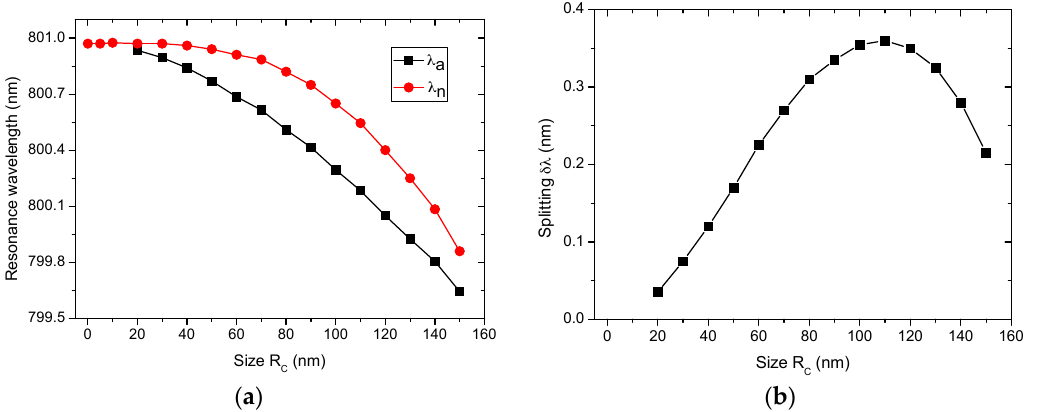
Figure 4. (Color online) Size dependence of ( a ) the resonance wavelength of the WGMs and ( b ) splitting of the resonance peaks ( δλ = λ (cid:2924) − λ (cid:2911) ). The nanocylinder of n c = 1.5 is embedded at (cid:1856) (cid:3030) = 4.85 μm . The reference wavelength of the unperturbed WGM is λ (cid:2925) = 800.966 nm .